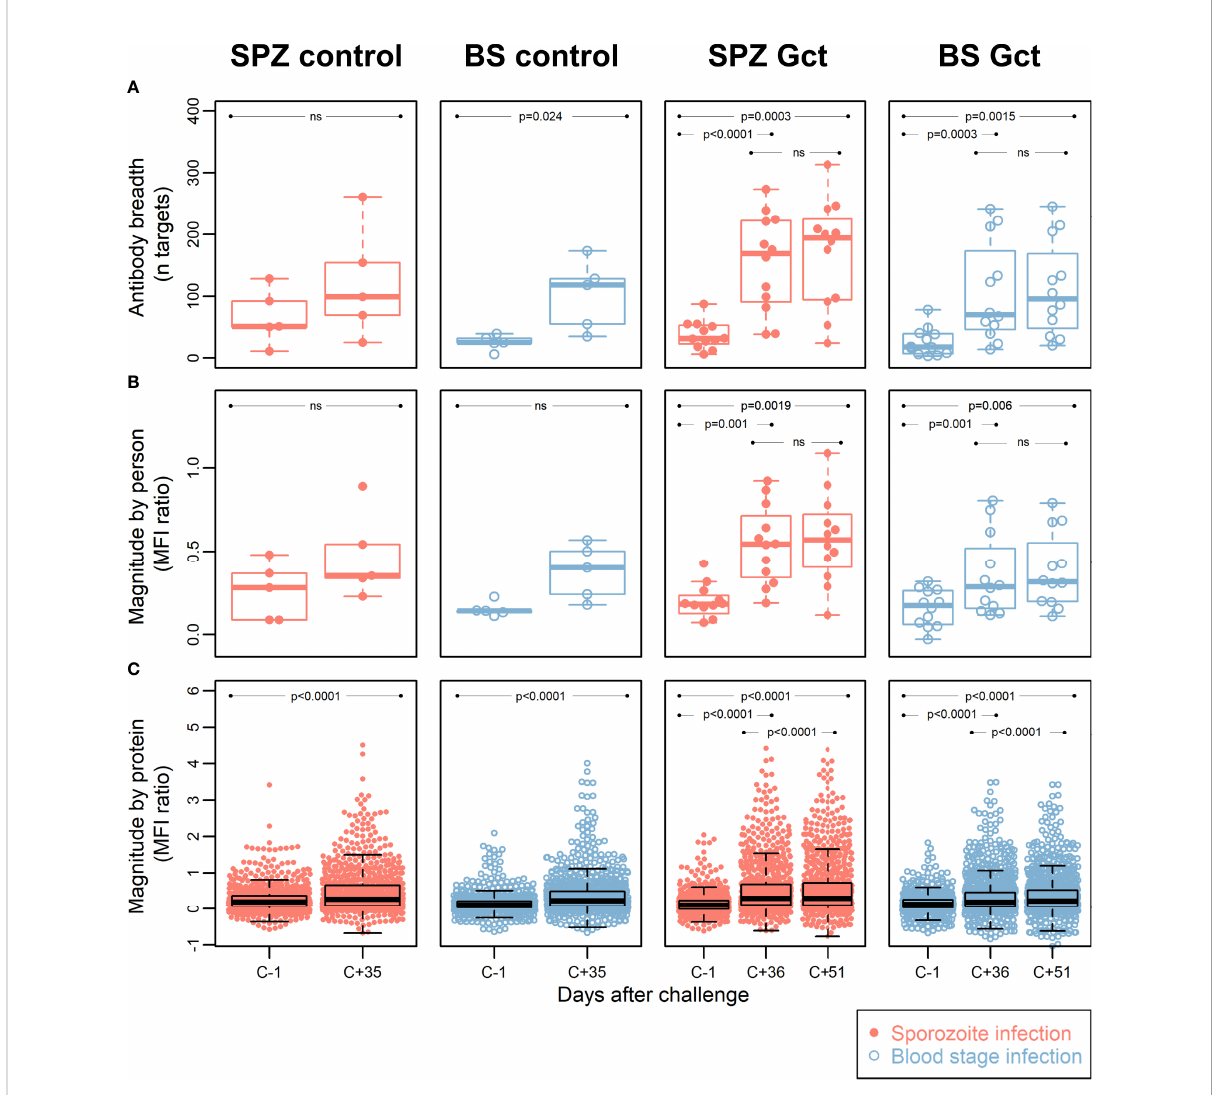
FIGURE 3 Antibody breadth and magnitude. Data points for each individual within each cohort group are represented with dots in a beeswarm pattern. Overlayed boxplots represent the median (thick line), interquartile range (box limits) and the 25 th /75 th percentiles plus 1.5*IQR (whiskers). (A) Antibody breadth is the number of protein targets (out of a total of 943) with responses above background, for each individual. For SPZ Gct, the mean MFI ratio of antibody responses to all proteins for one individual was -0.47 at C-1; this data point was not included in the plot, but the parameters of the relevant box plot were calculated from all data points. (B) Antibody magnitude is shown as the mean magnitude of response by each individual in a cohort group/timepoint to all protein targets. Magnitude of response is shown as a log2 MFI ratio, where 0 represent no change relative to background, and 1 represents doubling with respect to background. (C) Antibody magnitude is shown as the mean magnitude of response to each protein target by all individuals in a cohort group/timepoint, with units as in (B) P-values are from paired two- sided t-tests for difference between C-1 and C+35/36, C-1 and C+51, or C+36 and C+51, as indicated. MFI: median fl uorescence intensity; IQR: Interquartile range. P = P-value from paired t-tests. Ns = Not signi fi cant at p =